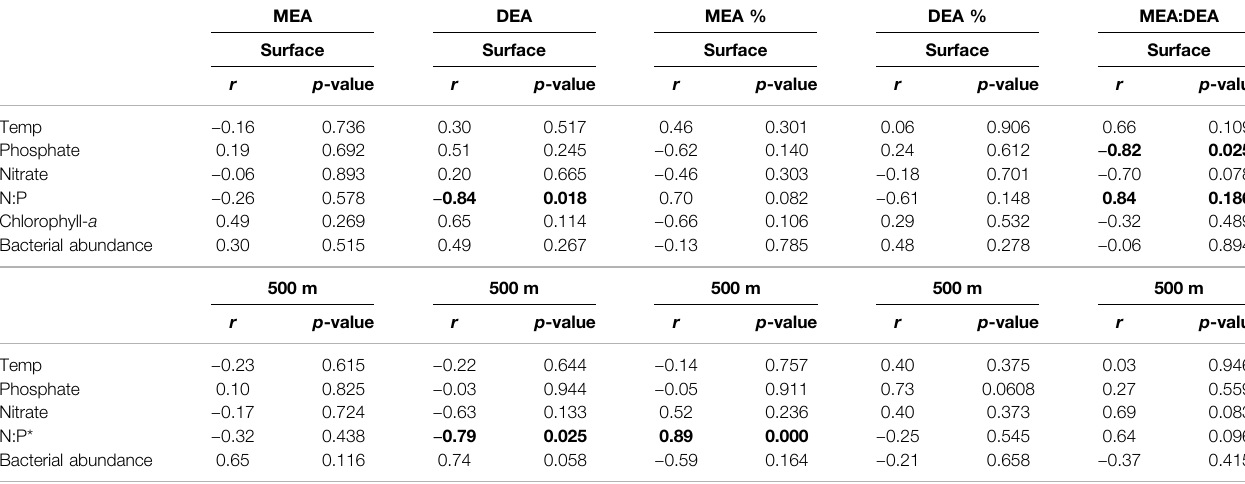
TABLE 1| Pearson ’ scorrelation coef fi cient ( r ) between thetotal, cell-free fractions (%)and ratios ofphosphomonoesterase activity (MEA) and/to phosphodiesteraseactivity (DEA) and temperature, phosphate, nitrate, chlorophyll- a , and bacterial abundance. MEA DEA MEA % DEA % MEA:DEA Surface Surface Surface Surface